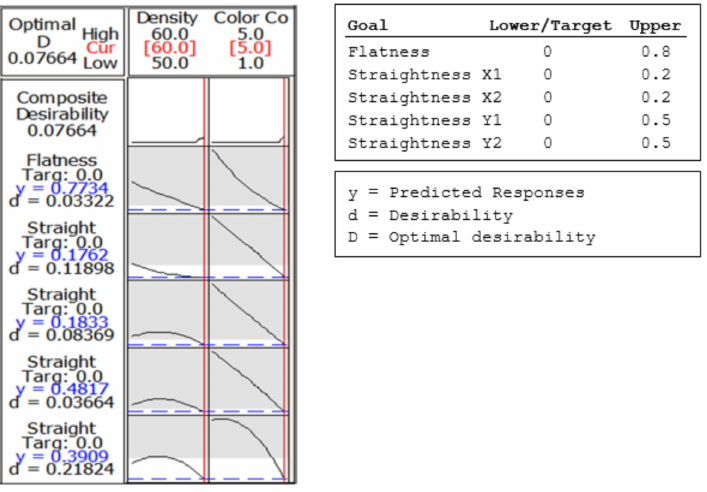
Figure 26. Optimization plot of Flatness and Straightness_X1; X2; Y1; Y2. The target value settings for input variables flatness and straightness are 0. The upper- value settings are 0.8 mm for flatness deviations, 0.2 mm for straightness deviations of the contours X1 and X2, and 0.5 mm for straightness deviations of the contours Y1 and Y2. In conclusion, the desirability can be obtained only for the combination of 60% supports density and clear